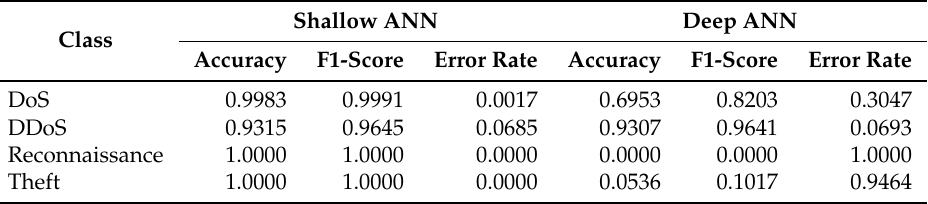
Table 8. Error rate for Type-A multi-class models using the Bot-IoT dataset.